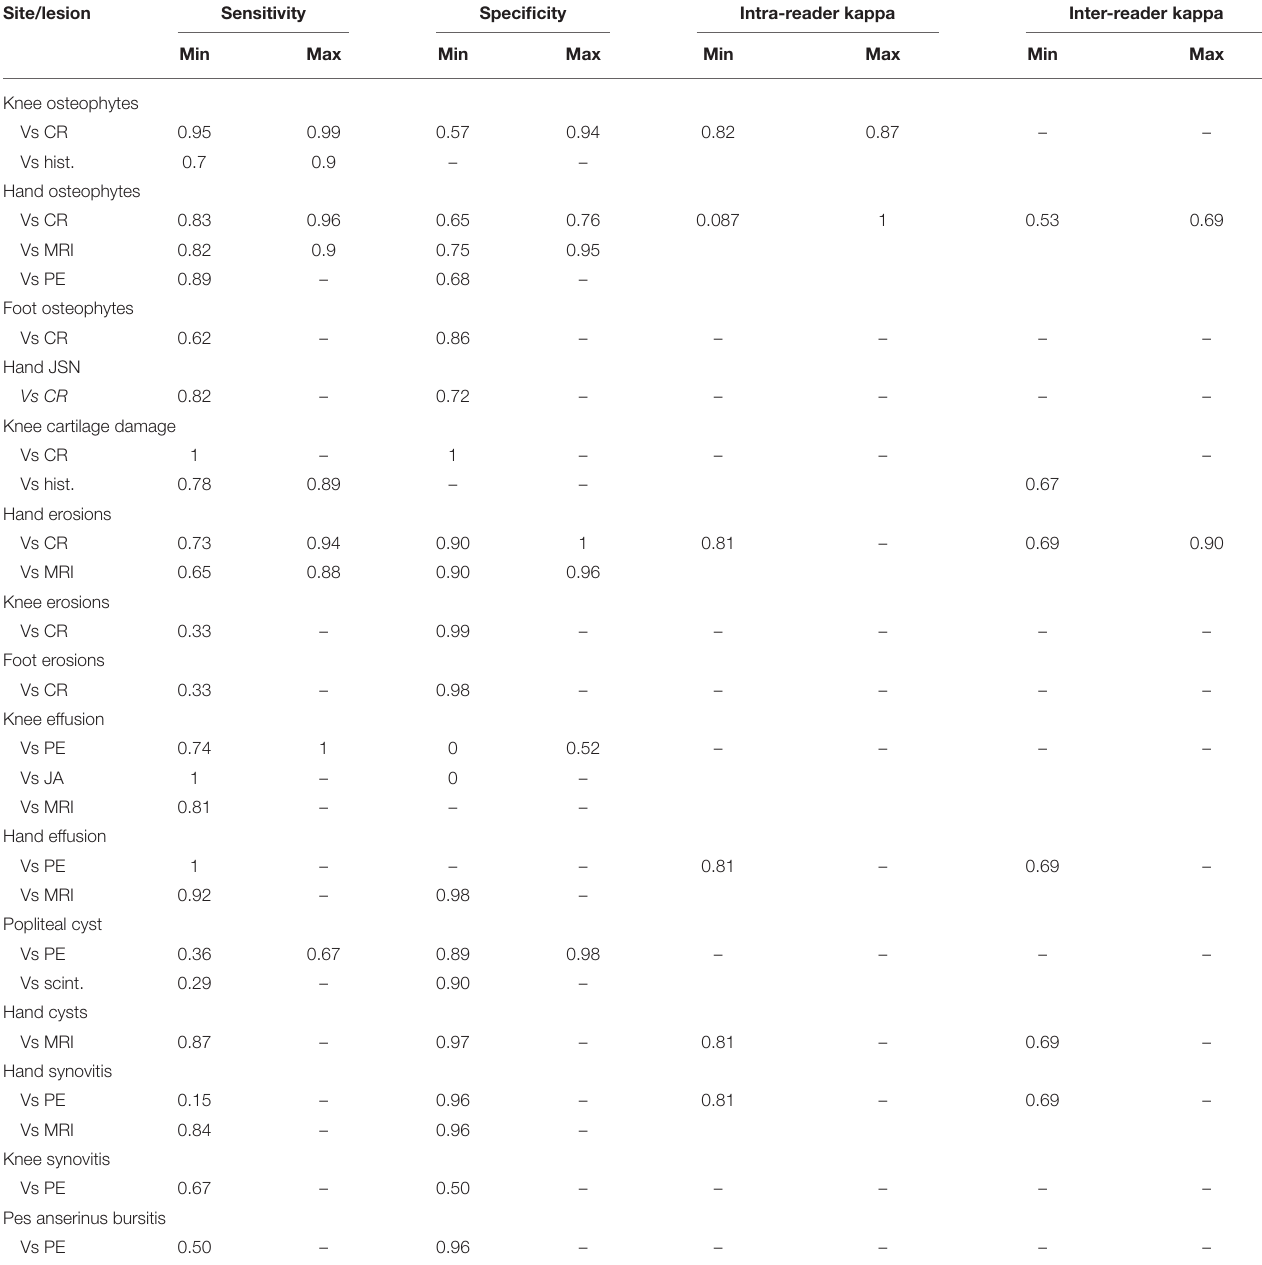
TABLE 7 | Performance of ultrasound to detect osteoarthritis elementary lesions and reliability. Site/lesion